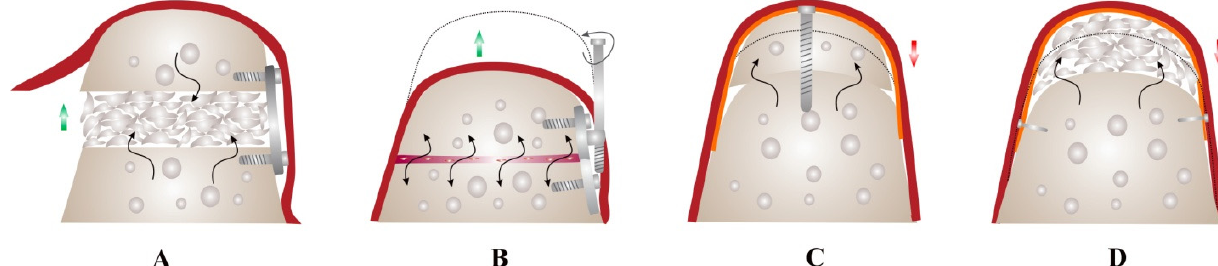
Figure 3. Vertical bone augmentation techniques. Ridge augmentation for implant